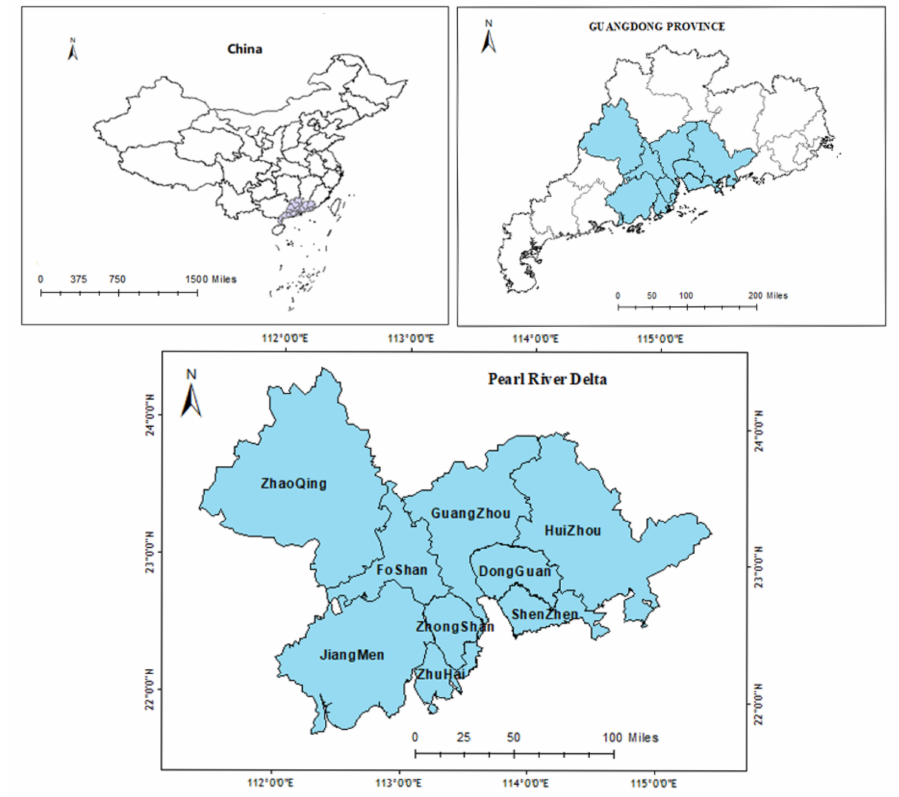
Figure 1. Location of the PRD in Guangdong Province in China and distribution of districts/counties. Data Source: The Resource and Environment Science and Data Center (https://www.resdc.cn/ (accessed on 13 February